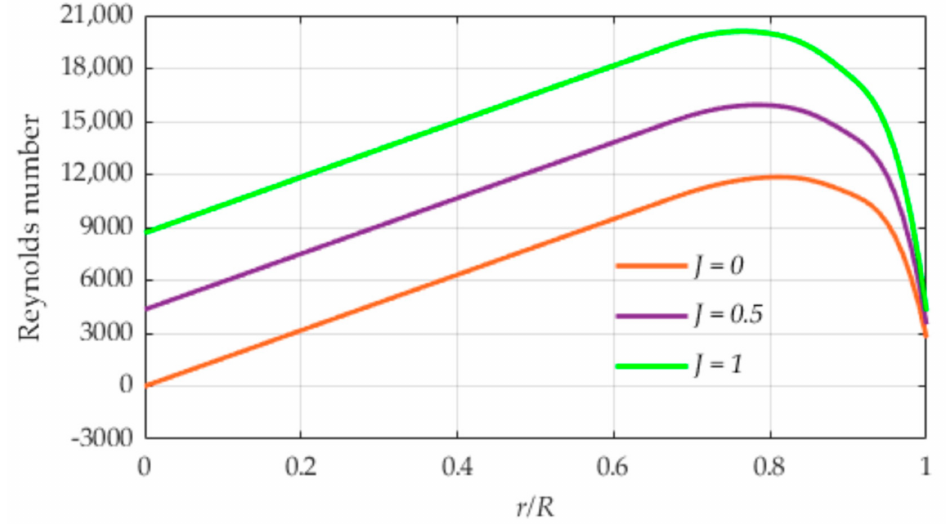
Figure 10. Span-wise distribution of the Reynolds number for the three investigated inflow